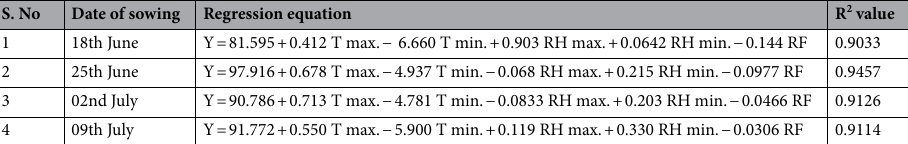
Table 2. Multiple regression equation for prediction of progress of Alternaria leaf spot severity at different dates of sowing in relation to weather parameters during Kharif , 2018.